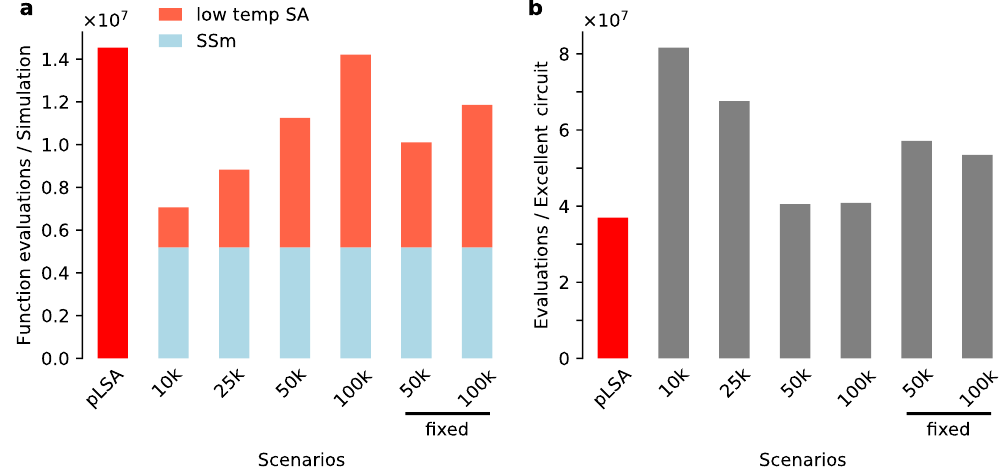
Figure 6. Performance of simulated annealing (pLSA) and the two-stage approach. ( a ) Total number of function evaluations per optimization scenario. The two-stage approaches shares the first explorative stage by scatter search (blue bars), after which different starting temperatures were used for low temperature SA; ( b ) Number of function evaluations per excellent gene circuit, defined as a circuit with an RMS < 22.0. In both panels, we replace 10 3 by the letter ‘k’ in scenario names. The two last columns (‘50 k’ and ‘100 k’) are labelled as “fixed” to signal a constrained search space was